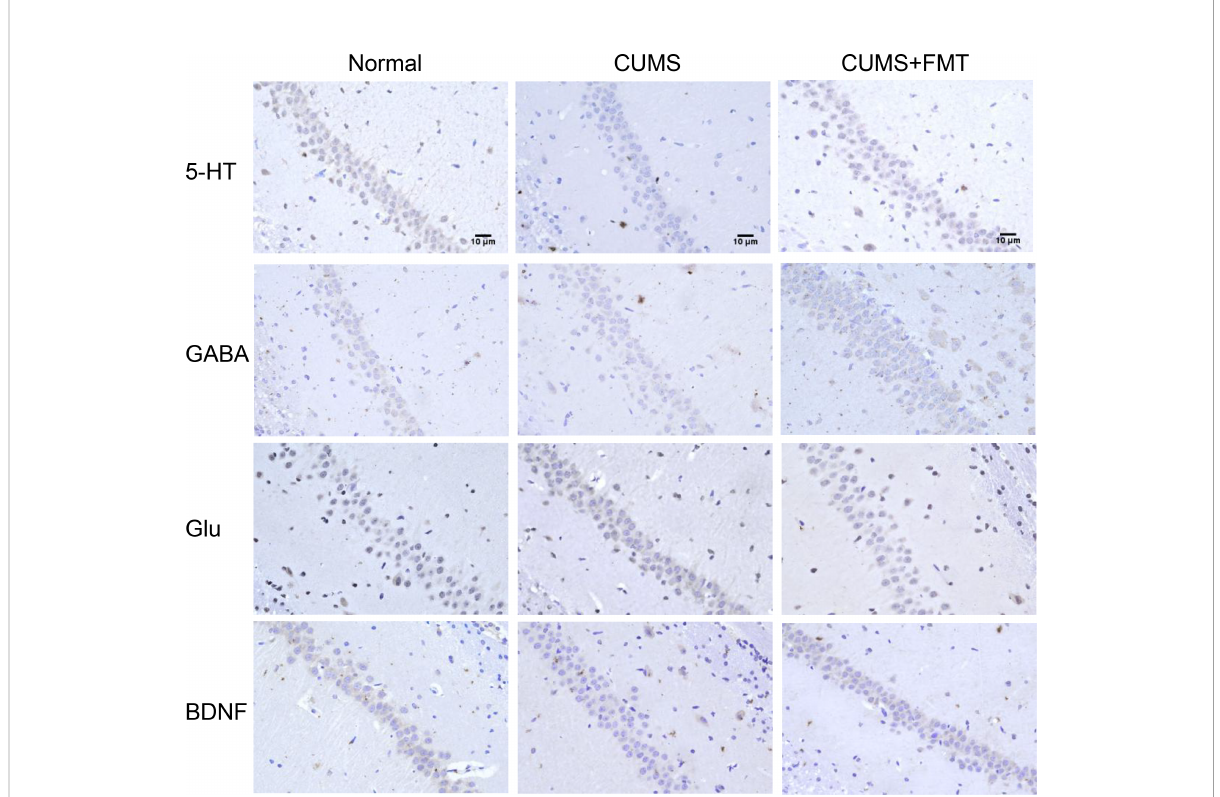
FIGURE 4 Levels of 5-HT, GABA, Glu, and BDNF in the hippocampus detected by immunohistochemistry (400× magni fi cation). 5-HT, 5-hydroxytryptamine; GABA, gamma-aminobutyric acid; Glu, glutamate; BDNF, brain derived neurotrophic factor; CUMS, chronic unpredictable mild stress; FMT, fecal microbiota